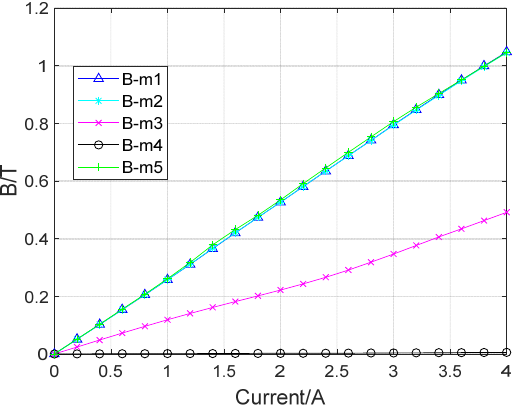
Figure 16. Change magnetic field intensity at the reference point of two C ‐ type magnetic circuits.